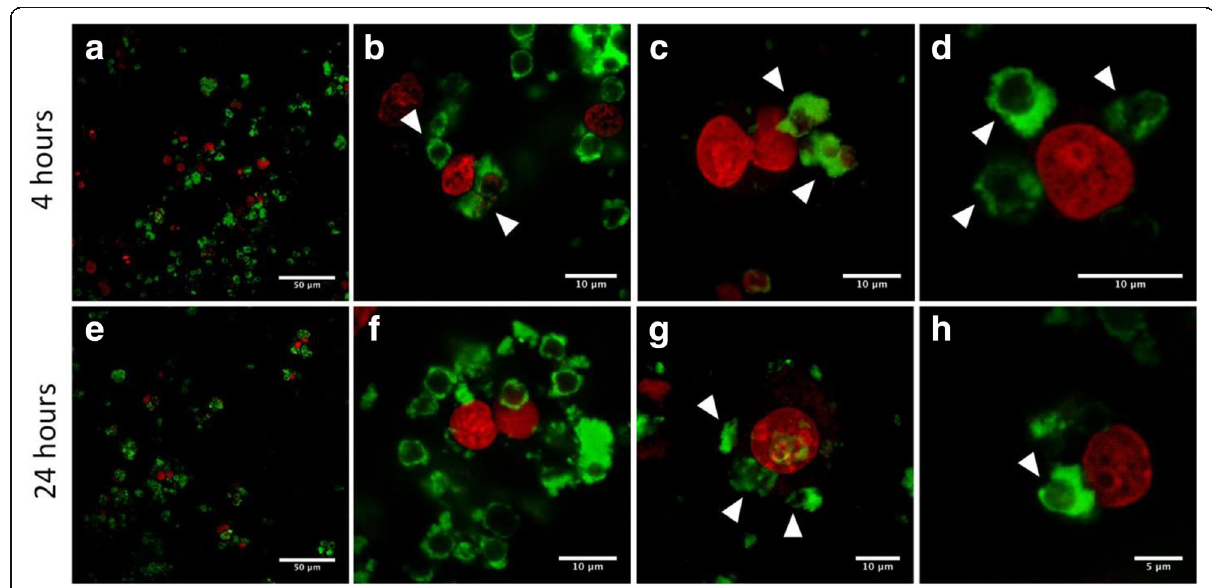
Fig. 9 Confocal images of the MH-S cells treated with the QD-encoded polyelectrolyte microcapsules coated with BSA. The upper row shows the images of the samples after 4 h of short-term incubation; the microcapsules are shown by white arrows ( a – d ). The lower row demonstrates the images of the samples after 24 h of long-term incubation; the microcapsules are shown by white arrows ( e – h ). The nuclei of the macrophages were counterstained with far-red DNA stain